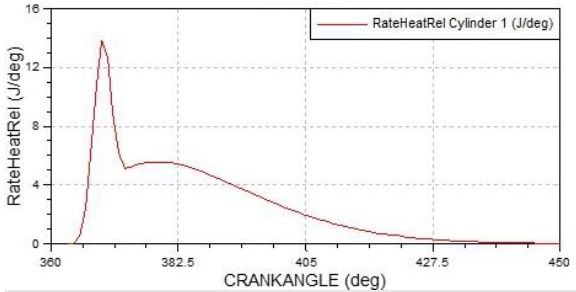
Fig. 7. Heat release rate modeled by double Vibe function for Lifan engine